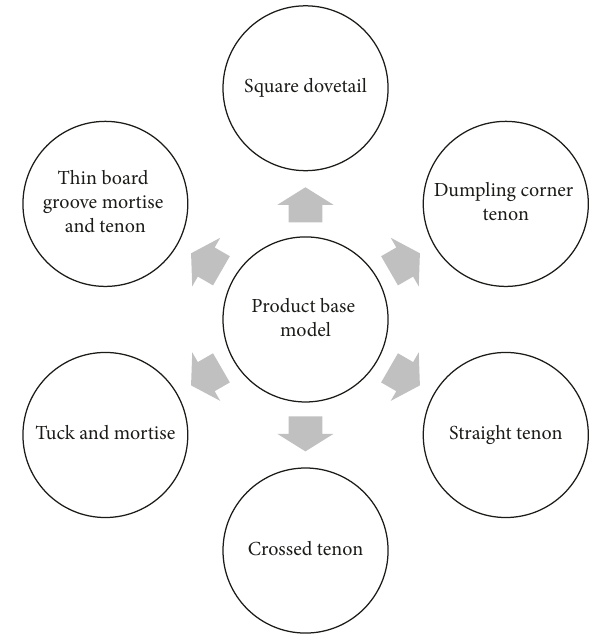
Figure 4: Tenon structure